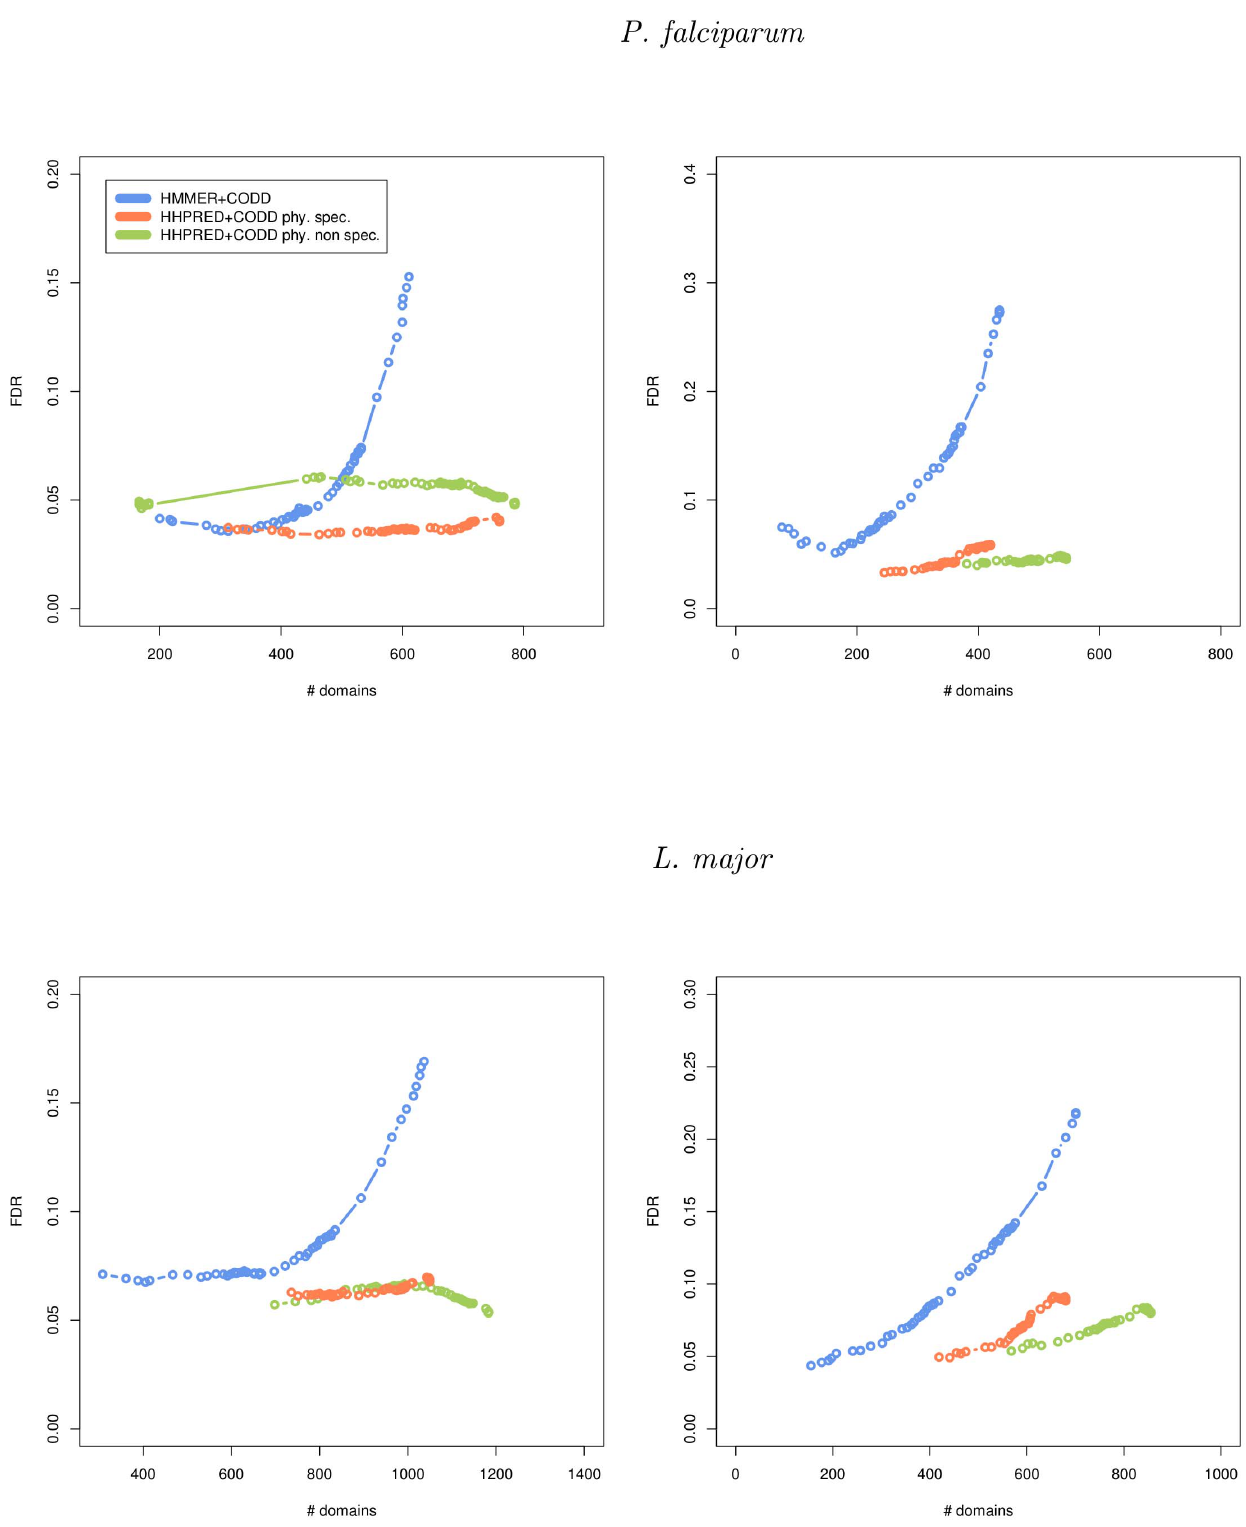
Figure 3. Sensitivity and accuracy of HHPRED + CODD and HMMER + CODD using the known Pfam domain occurrences for certifications. This figure reports the number of new domains (x-axis) certified by HHPRED + CODD (in orange and green for the phylum specific and non-specific approaches, respectively) and HMMER + CODD (blue) using local (left) and global (right) alignments for various FDR thresholds (y-axis).